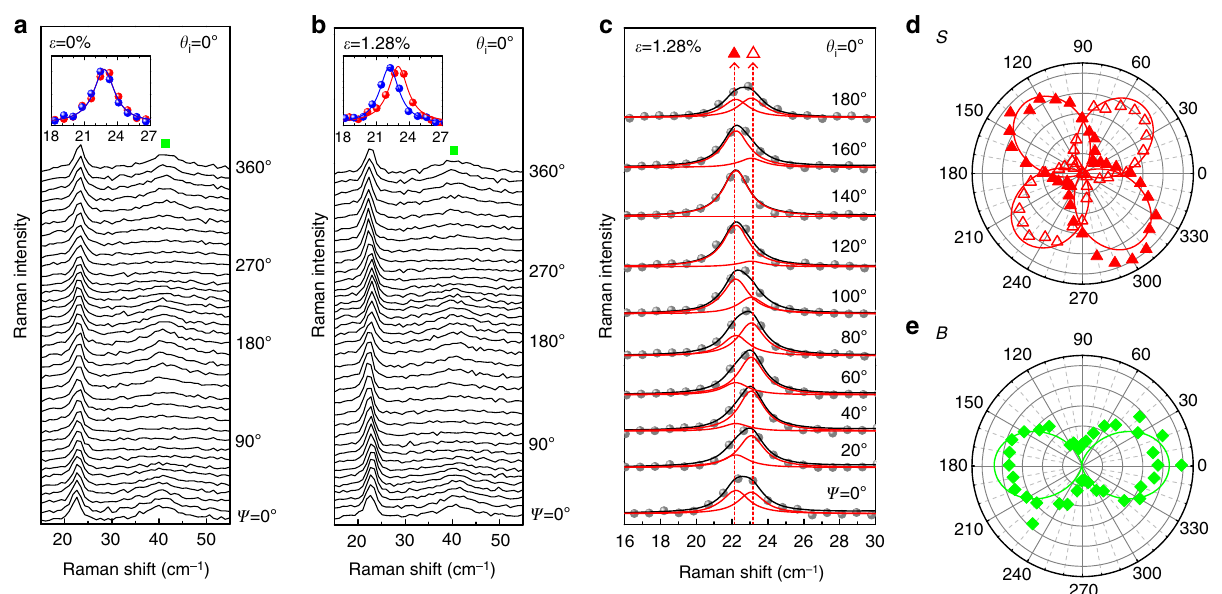
Fig. 5 Polarization dependence of interlayer Raman modes. Polarized Raman spectra of bilayer MoS 2 a without and b with strain ( ε = 1.28%) in the low- frequency region. The incident polarization ( θ i ) is fi xed at 0° and the spectra are measured as a function of ψ de fi ned in Fig. 1a. The insets compare spectra taken for ψ = 40° (blue) and 130° (red) and show the splitting for the case with strain. c Representative fi tting results for split shear modes. Normalized polar plots of d shear ( S , S − , and S + ) and e breathing ( B ) modes